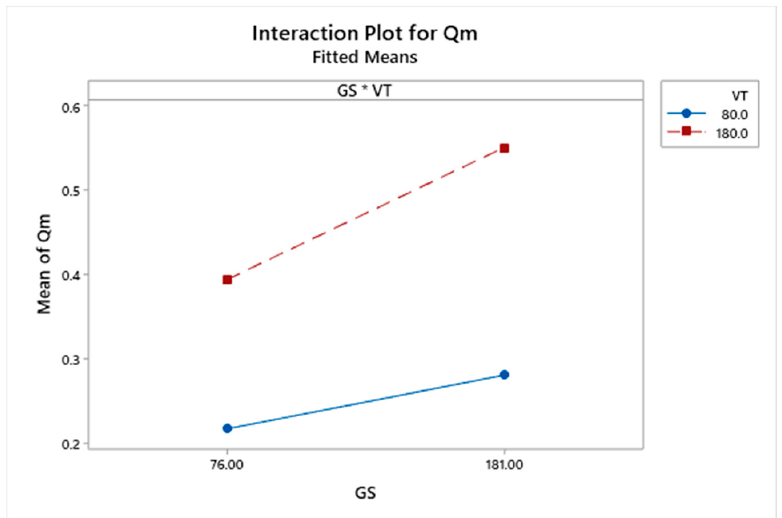
Figure 7. Interaction plot for material removal rate Qm.